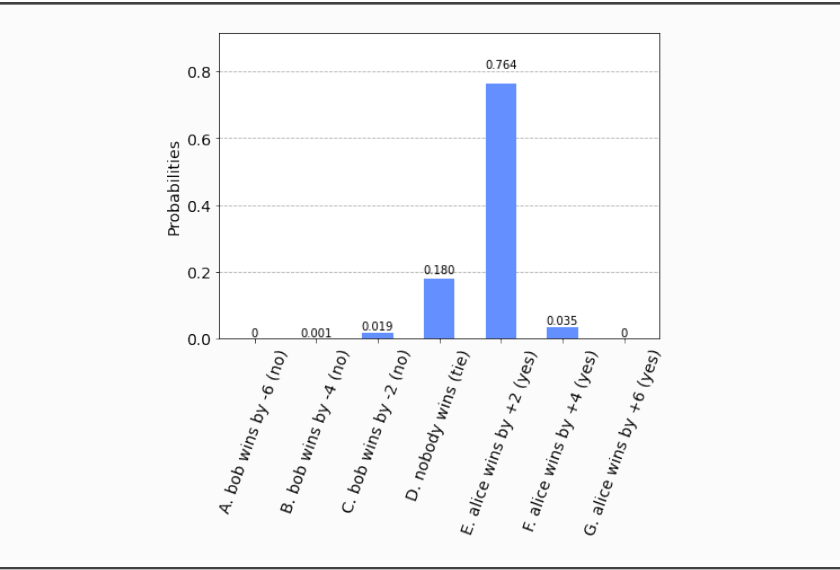
Figure 13. The possible outcomes and their probabilities when r A = 0.30 and r B =